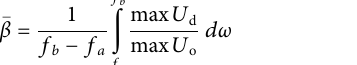
signi fi cantly but still increase slowly. Second, the areas between PDFs and the x axis at the two sides of the reference line are almost the same. This is checked by the ratio of areas shown in Figure 7B. So, the probability of The PDFs become fl atter, which is consistent with the increase in standard deviation shown in Figure 7A. Thus,